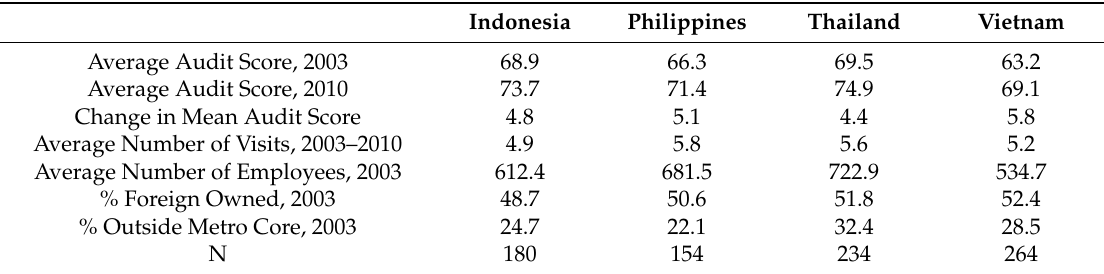
Table 1. Descriptive Statistics of Factory